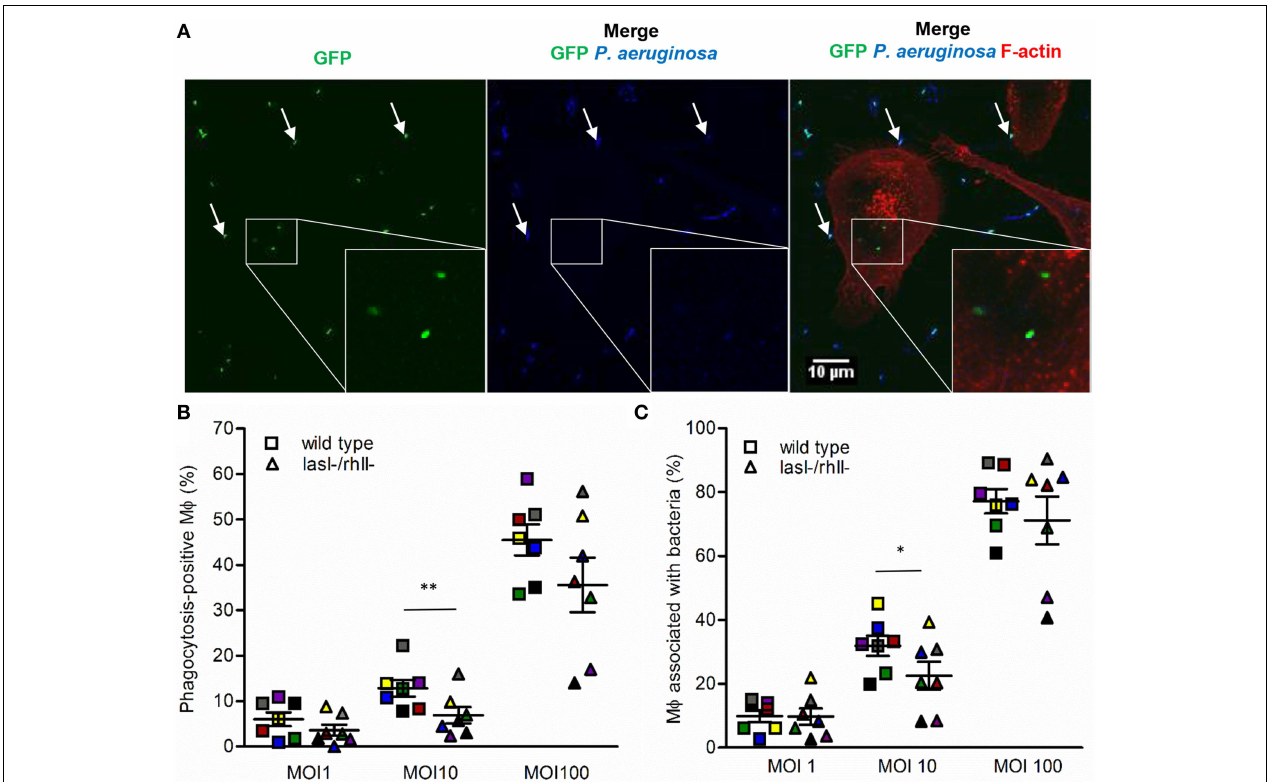
FIGURE 1 | Binding and phagocytosis of wild type P. aeruginosa and its lasI-/rhlI- mutant. (A) Macrophages were infected with GFP (green) wild type bacteria or lasI-/rhlI- mutant, stained for P. aeruginosa (blue) and F-actin (red), and analyzed by LSCM. White squares show three ingested bacteria distinguished by sole GFP (green). White arrows point to bound bacteria recognized by combined GFP (green) and P. aeruginosa (blue). Bar 10 µ m. (B) Quantification of phagocytosis presented as the percentage of phagocytic-positive (containing ingested bacteria) cells among total macrophages. (C) Quantification of binding presented as the percentage of cells containing bound and ingested bacteria (associated bacteria) among total macrophages. Shown are the mean ± SE of seven independent experiments performed at separate days from different donors (color coded). The means ± SE are based on 100–200 cells for each condition per experiment. Significant differences were considered at * P < 0 . 05 and ** P < 0 . 01 , as calculated by two-tailed paired Student’s t